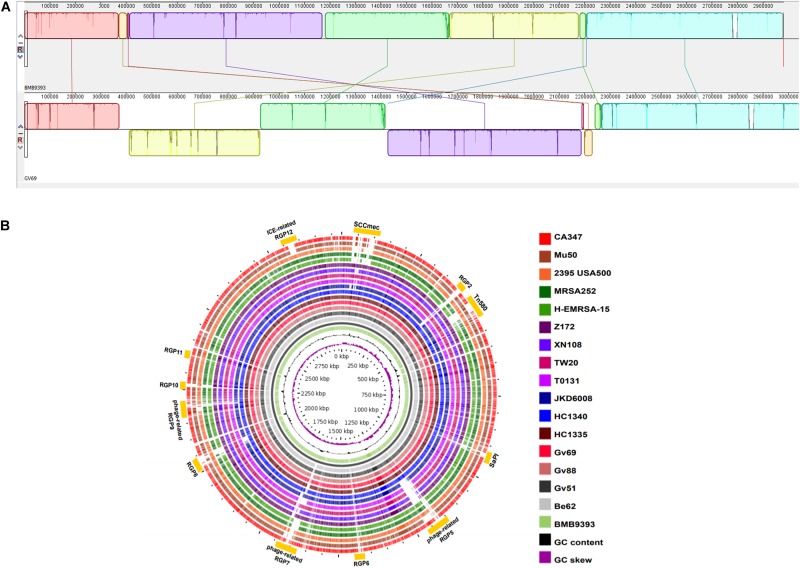
Genomic organization. (A) Genome alignments of ST239-BRC strains BMB9393 and GV69 highlighting the distinct syntenic patterns among them. The genome of the strain BMB9393 (ST239-BRC) was used as reference. (B) The innermost ring (purple) plots the G+C skew of the reference, followed by its G+C content (black). The third ring represents the reference chromosome of strain BMB9393 and its coordinates. The following colored rings depict BLASTN (>80% identity and e-values < 10-10) comparisons obtained by GVIEW, between the chromosome of BMB9393 and those of ST239-BRC strains (Be62, Gv51, Gv88, Gv69, HC1335, HC1340), ST239-INTC (JKD6008, T0131, TW20, XN108, Z172), and non-ST239-INTC (H-EMRSA-15, MRSA252, 2395, Mu50, CA-347). The outermost, interspaced rings (in dark yellow) represent the localization of the predicted RGPs in the BMB9393 chromosome, and the labels of each region as listed in Table 3.